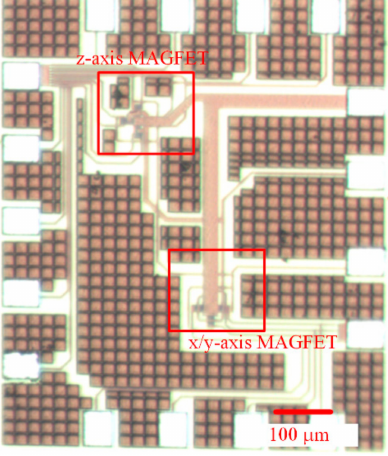
Figure 5. Optical image of the magnetic micro sensor (MMS) chip.